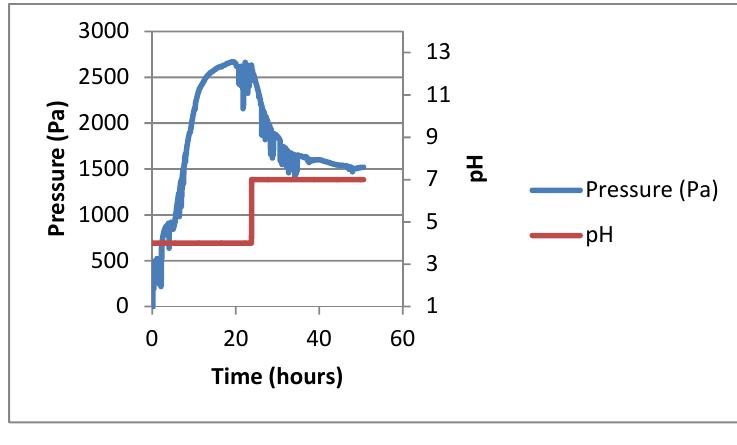
Figure 4. The representative pH response from pH 4.0 to 7.0 of the 400 μ m hydrogel in the Han sensor.